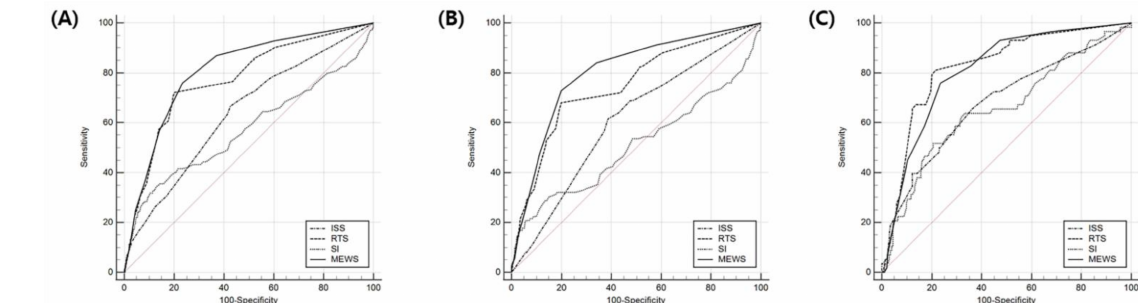
Figure 2. Receiver operating characteristic curve analyses of the ISS, RTS, SI, and MEWS for predicting in-hospital mortality. ( A ) Total TBI group: the AUCs of the ISS, RTS, SI, and MEWS were 0.638 (95% CI, 0.603–0.672), 0.742 (95% CI, 0.709–0.772), 0.524 (95% CI, 0.489–0.560), and 0.799 (95% CI, 0.769–0.827), respectively. ( B ) Isolated TBI group: the AUCs of the ISS, RTS, SI, and MEWS were 0.608 (95% CI, 0.574–0.641), 0.750 (95% CI, 0.719–0.778), 0.510 (95% CI, 0.476–0.544), and 0.803 (95% CI, 0.774–0.829), respectively. ( C ) Combined TBI group: the AUCs of the ISS, RTS, SI, and MEWS were 0.679 (95% CI, 0.619–0.735), 0.824 (95% CI, 0.773–0.868), 0.657 (95% CI, 0.597–0.715), and 0.809 (95% CI, 0.757–0.855), respectively.